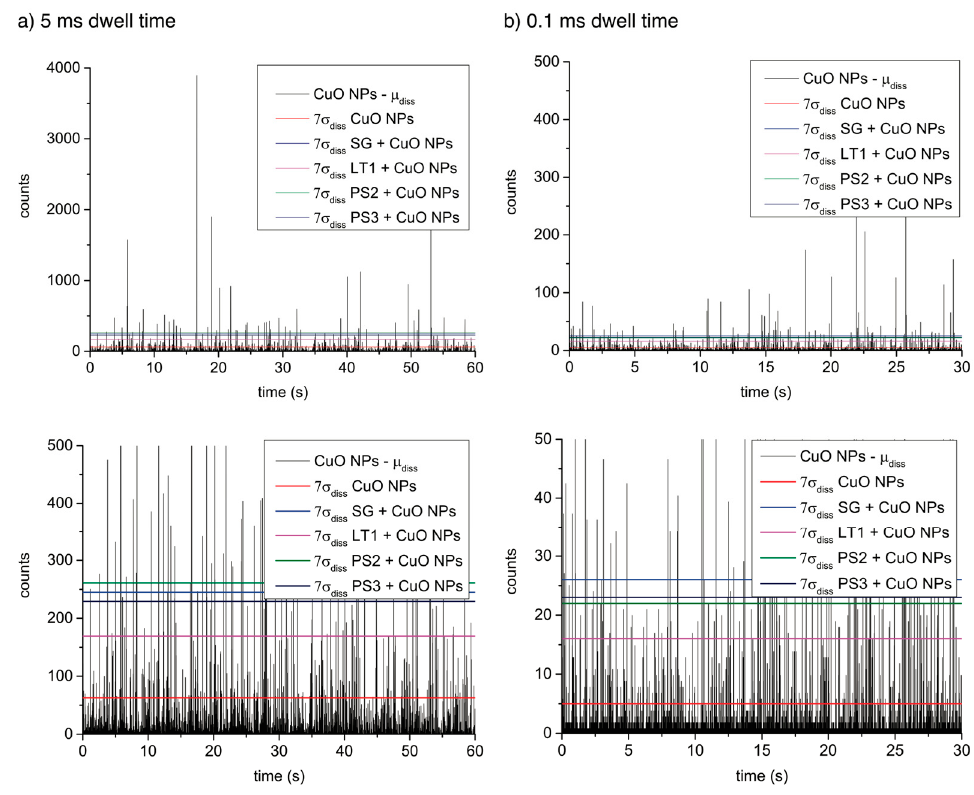
Figure 3. Raw spICP-MS data of the engineered CuO NPs (with the mean dissolved background subtracted) compared to the level of 7 σ diss of the different samples at a dwell time of 5 ms ( a ) and 0.1 ms ( b ).